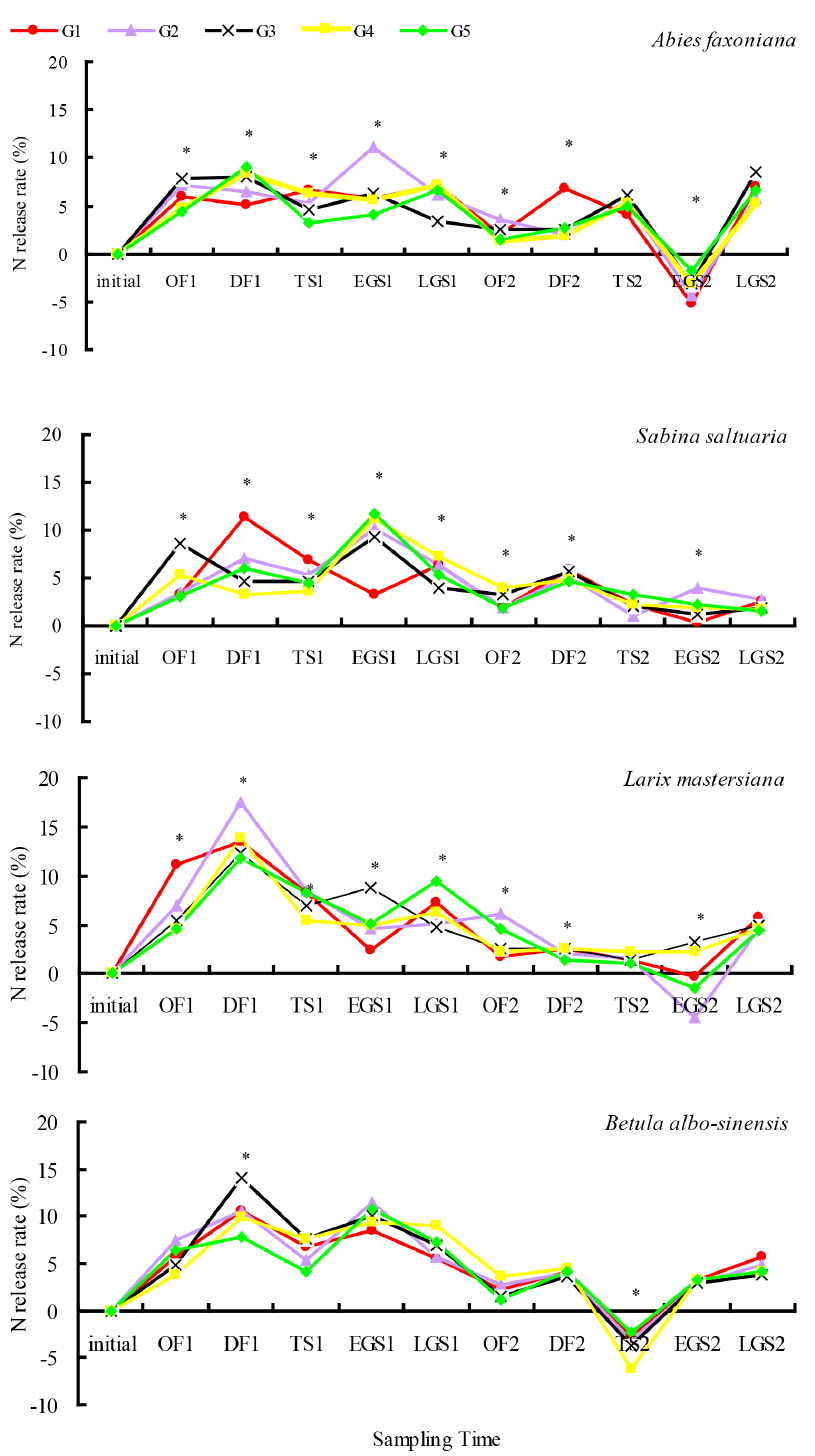
Figure 4. N release rate during litter decomposition from gap center to closed canopy at different decomposition stages over 2 years (mean ± SD , n =5). The symbols ‘‘*’’ indicate the significant difference among treatments (LSD’s multiple range test; P , 0.05). Abbreviations: OF=onset of freezing stage; DF=deep freezing stage; TS=thawing stage; EGS=early growing season; LGS=late growing season; G1=gap 1, gap center south; G2=gap 2, gap center north; G3=gap 3, canopy edge; G4=gap 4, expanded edge; G5=gap 5, closed canopy.